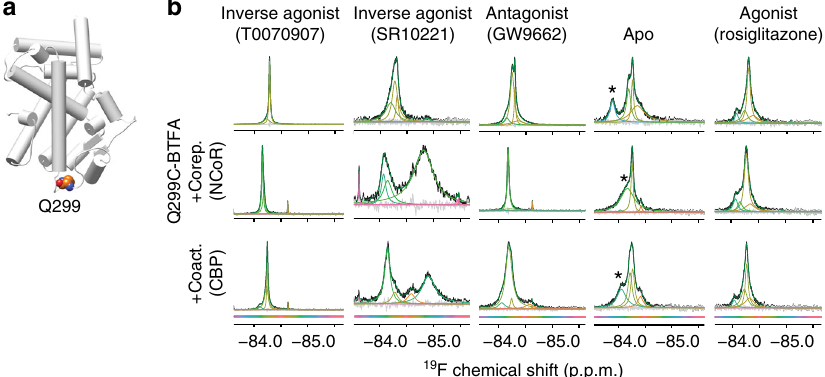
Fig. 6 A speci fi c omega loop conformation is induced by the inverse agonist T0070907. a Location of the Q299 probe on the omega loop. b 19 F NMR spectra of PPAR γ Q299C -BTFA alone (apo) or bound to the indicated small molecules (top panel). Either corepressor (CoRNR) or coactivator (LxxLL) peptides were added to the apo and ligand complexes (lower two panels). The color of the deconvoluted peaks denotes chemical shift as shown by the color bar. Asterisk denotes signal that likely originates from the native cysteine (C313; see Supplementary Fig.